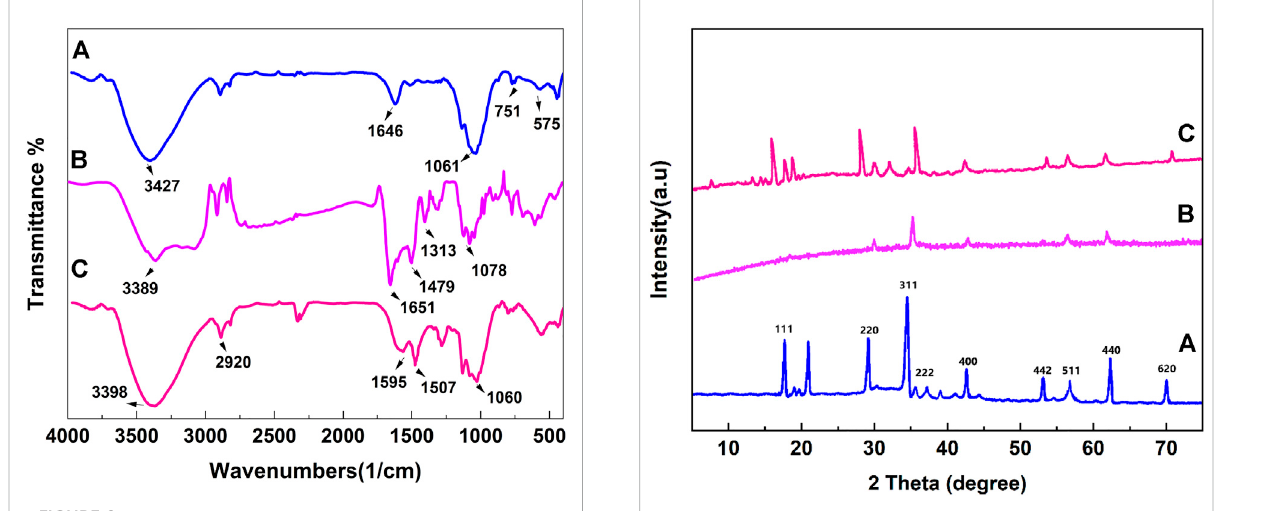
FIGURE 2 FTIR spectra of the prepared MnFe 2 O 4 (A) , poly(aniline- co - melamine) (B) , and poly(aniline- co -melamine) @MnFe 2 O 4 (C)